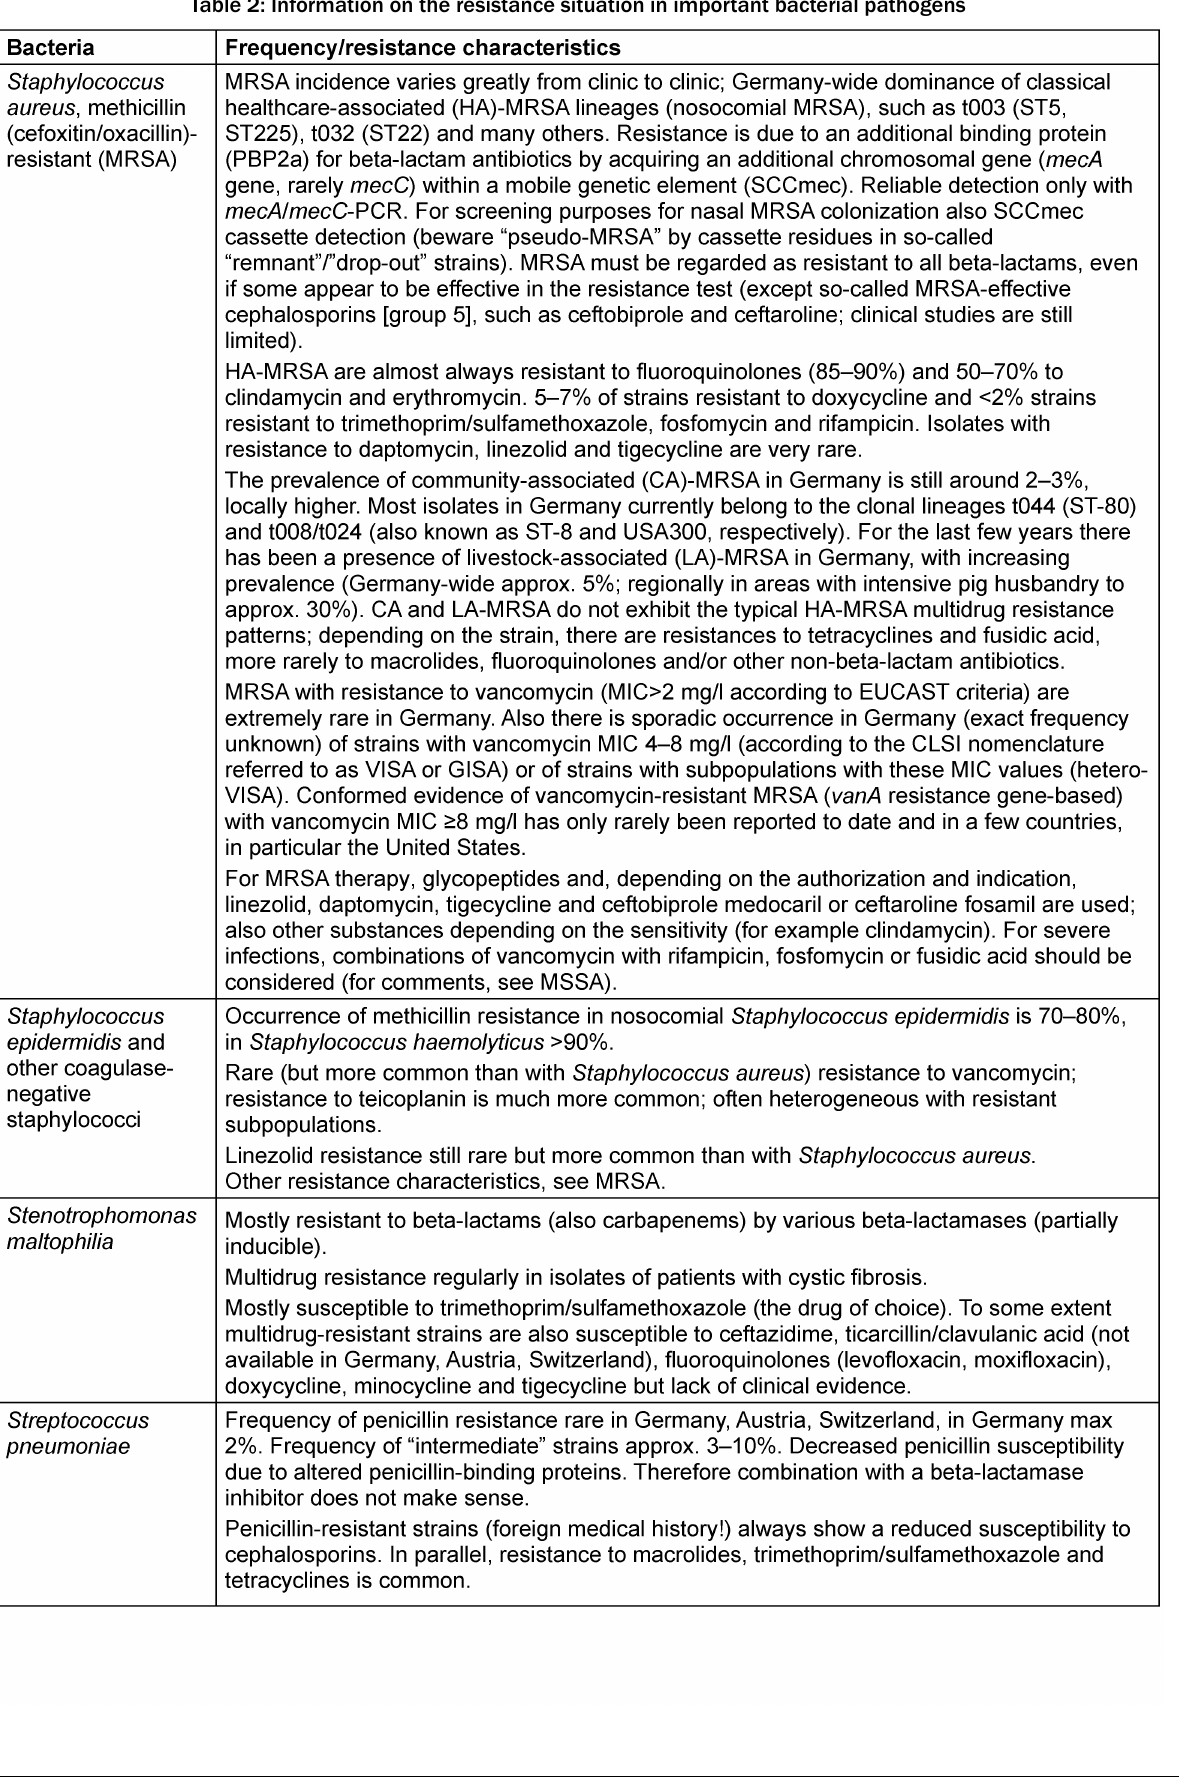
Table 2: Information on the resistance situation in important bacterial